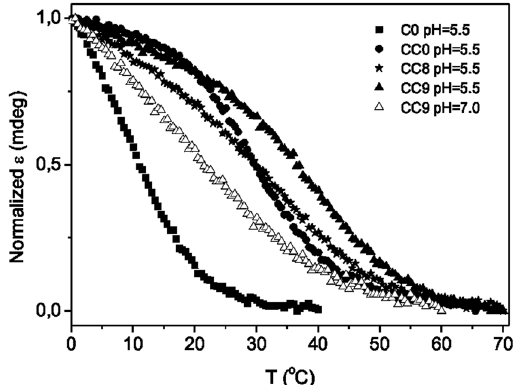
Figure 3. Thermal stability of psC-containing i-motifs. CD melting curves of C0 , C7 , CC0 , CC8 and CC9 . Experimental conditions: [oligonucleotide] = 20 μ M, 25 mM of buffer solution (cacodylate (pH 5.5) or phosphate (pH 7) and 100 mM